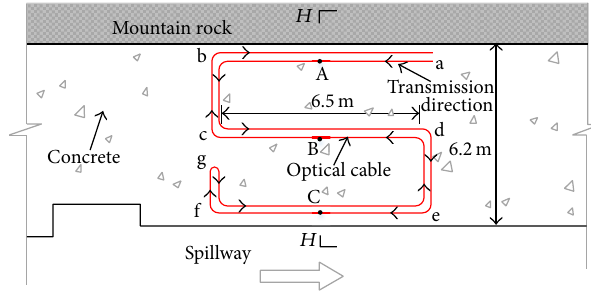
Figure 9: Layout of cable in the concrete block.